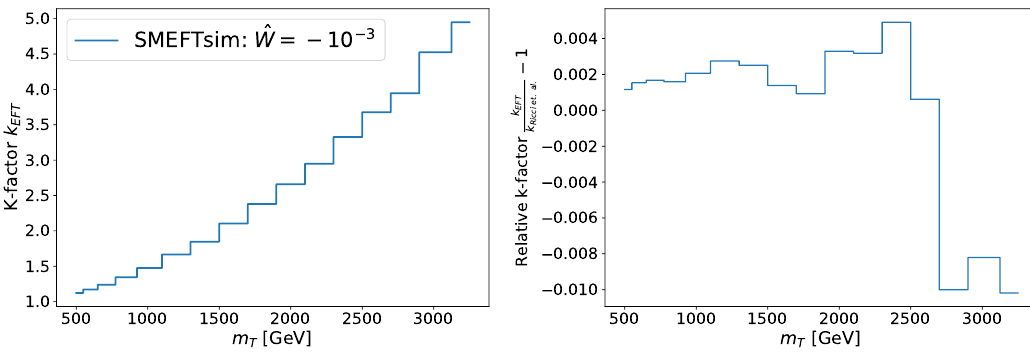
Figure 27 . Left: the EFT K -factor for high-mass charged-current DY production at the HL-LHC as a function of m T , the transverse mass of the neutrino-lepton pair, for ˆ W = − 10 − 3 . Right: the same quantity, now compared to the corresponding k-factors provided by the authors of